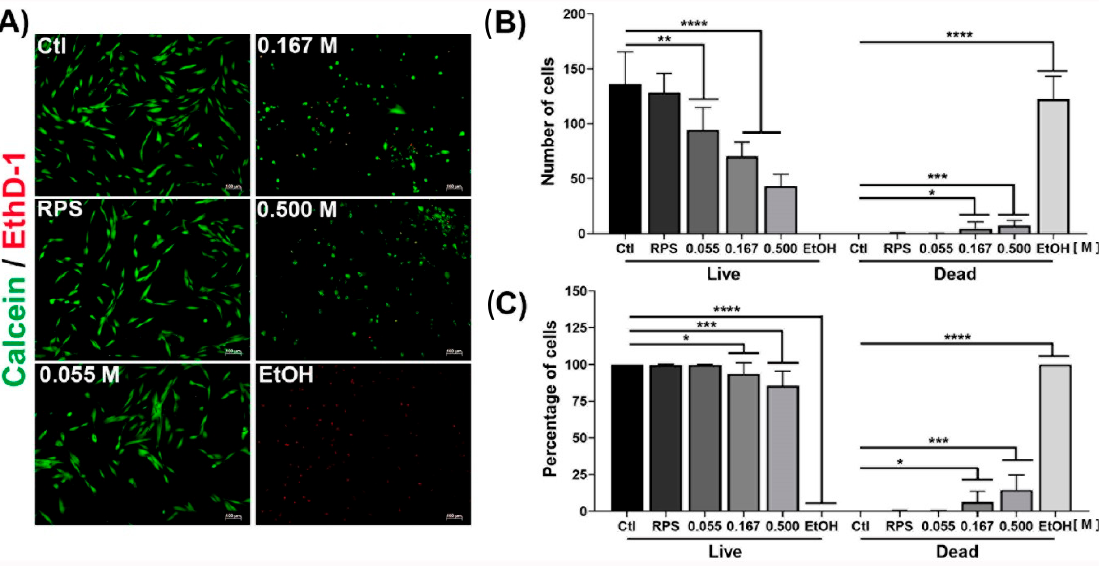
Figure 8. Viability of fibroblasts exposed to electrosprayed silver nanoparticles. The effect of AgNPs from porcine skin on fibroblast viability was measured. ( A ) Micrographs of viable cells (calcein/green) and dead cells (ethidium homodimer/red); ( B ) number of living and dead cells; and ( C ) percentage of living and dead cells. Experiments were performed in triplicate. Untreated cells and ethanol were used as negative and positive controls, respectively. Results are expressed as the mean ±